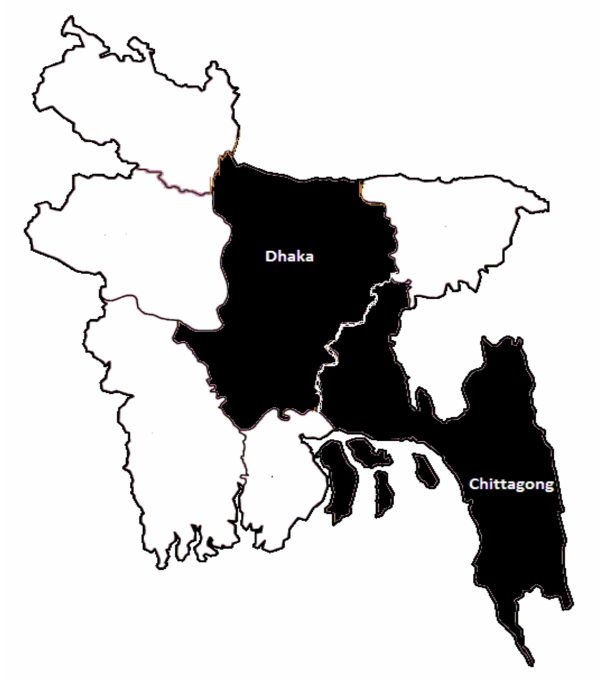
Figure 1. The black shading indicates the study